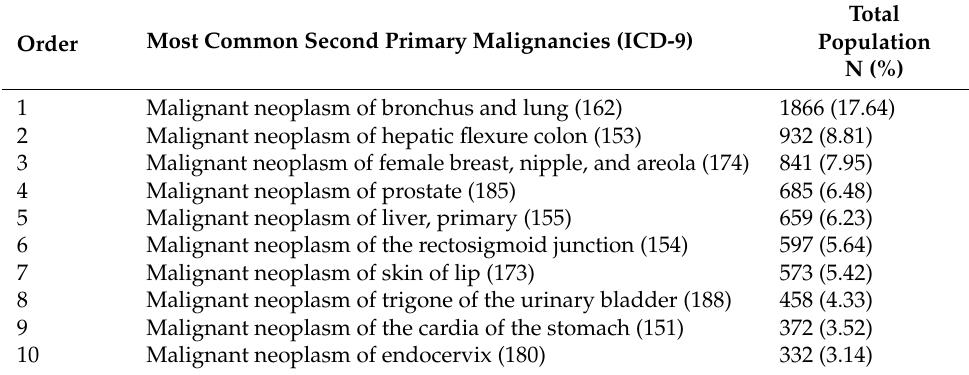
Table 4. Most common second primary malignancies in patients with